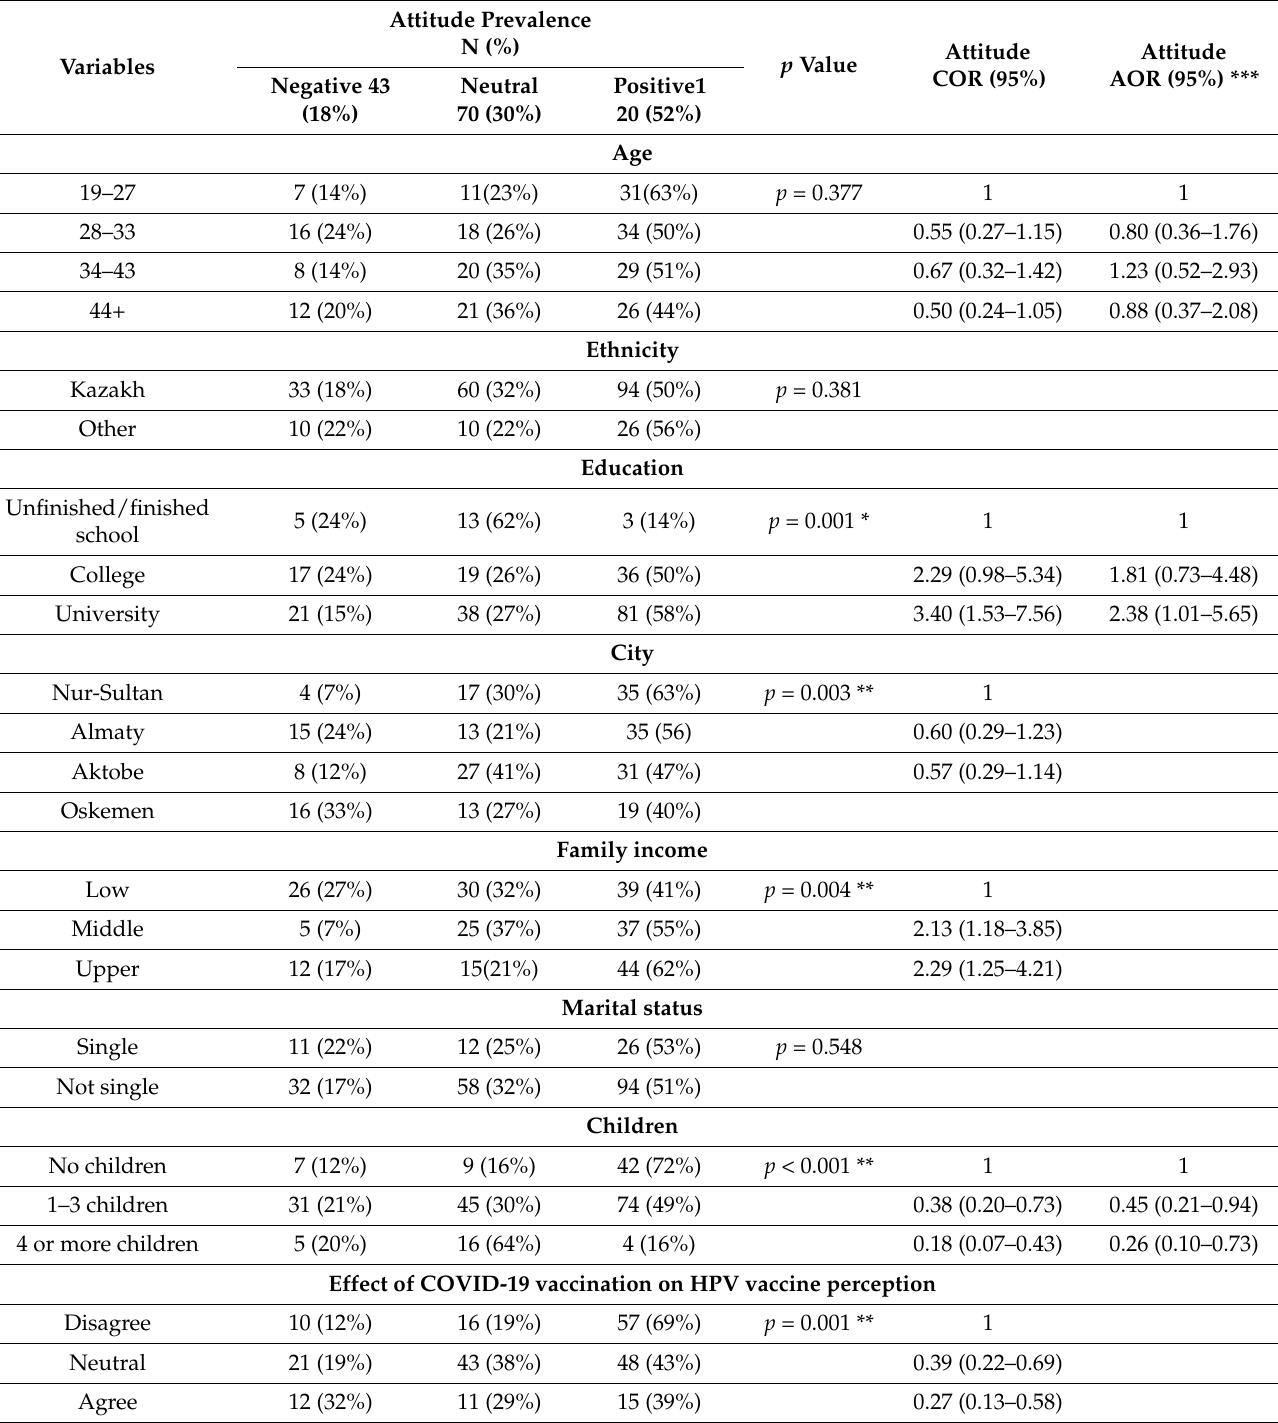
Table 4. Attitude towards HPV vaccination among women including social and demographic characteristics and contextual factors, (N =